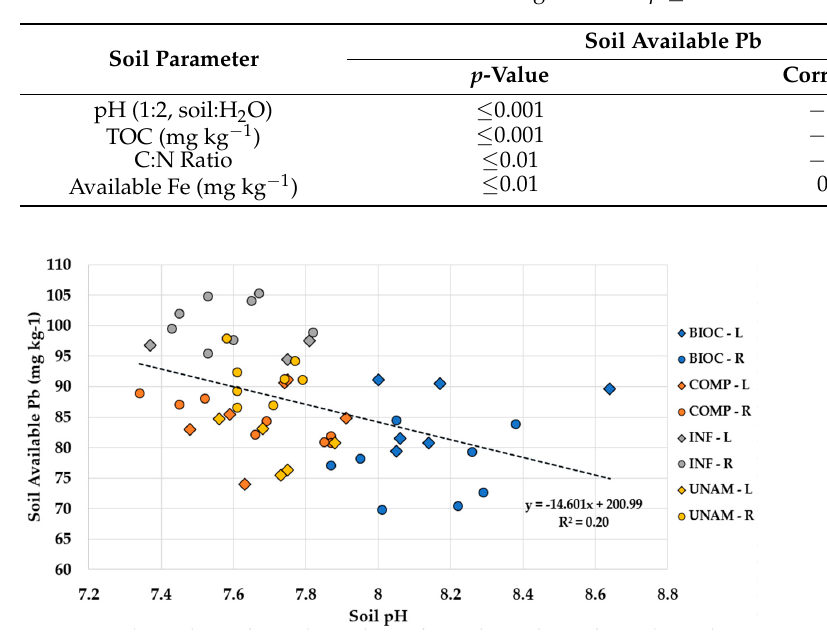
Table 5. p -Values and correlation coefficients for the relationship between soil available lead (Pb) and pH, total organic carbon (TOC), C to nitrogen (N) ratio (C:N), and available iron (Fe) across all treatments and plant species + lab incubated soil. Statistical analysis was conducted using Pearson’s correlation test and observations were considered significant at p ≤ 0.05.